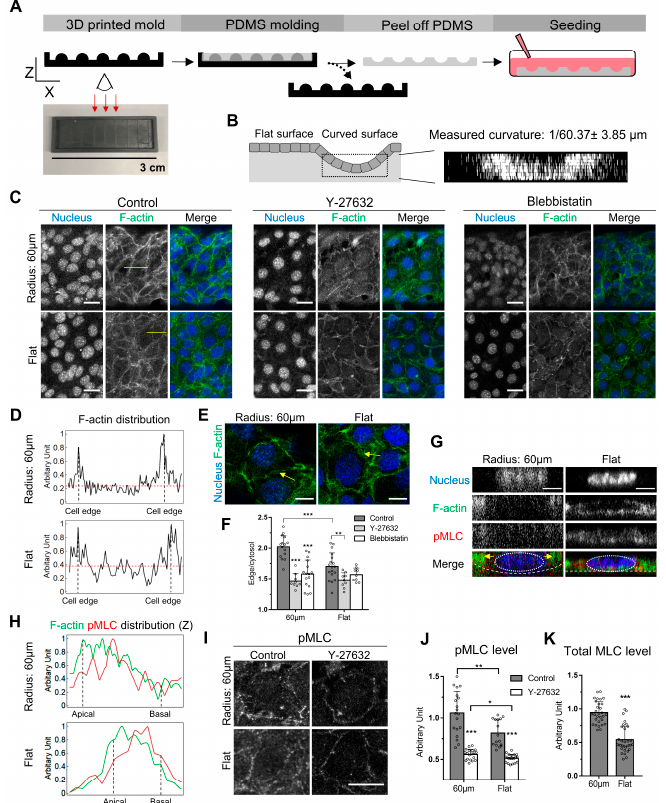
Figure 1. Curvature-dependent cortical actin is regulated by myosin phosphorylation in EpH4-EV cells. ( A ) The fabrication steps of the channels with concaved curvature of 1/60 µm using 3D printed molds are shown. ( B ) The schematic shows how the continuous epithelium is formed over the substrate on both the curved and flat surfaces. The reconstructed XZ images were used to confirm that the desired curvature was achieved (n = 6). ( C ) Different F-actin distribution patterns between cells on the curved and flat surfaces were distinguished by fluorescent phalloidin staining. The cells on the curved surface and the flat surface were treated with DMSO, Y-27362, or Blebbistatin for 2 h prior to the staining of F-actin. The nuclei were marked by DAPI staining. ( D ) The line scans of